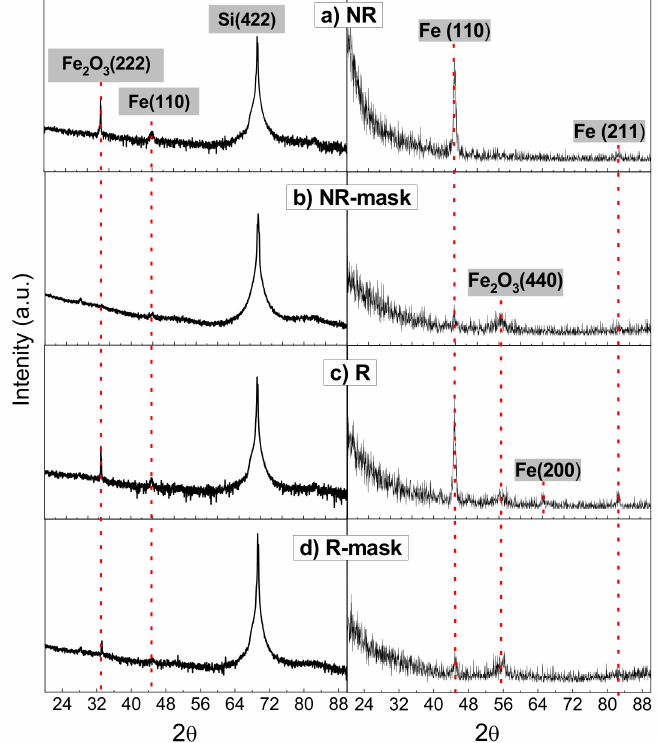
Figure 3. XRD diagrams in Bragg-Brentano configuration (left column) and Grazing Incidence configuration at 0.5 ◦ with respect to the substrate plane (right column) for: ( a ) NR sample: no azimuthal rotation of the substrate; ( b ) NR-mask: no azimuthal rotation of the substrate and use of mask (one side deposition); ( c ) R sample azimuthal rotation of the substrate; and ( d ) R-mask: azimuthal rotation of the substrate and use of collimation mask (two sides